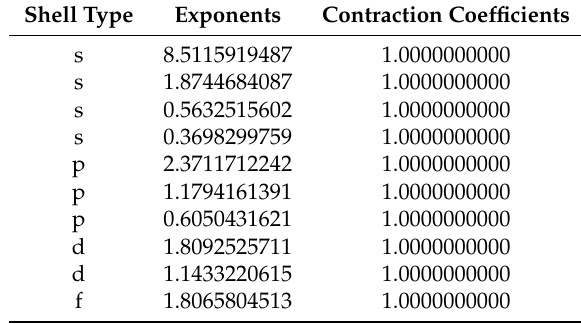
Table A17. Parameters of the cc-TZVP auxiliary basis set of Hydrogen. Parameters taken from